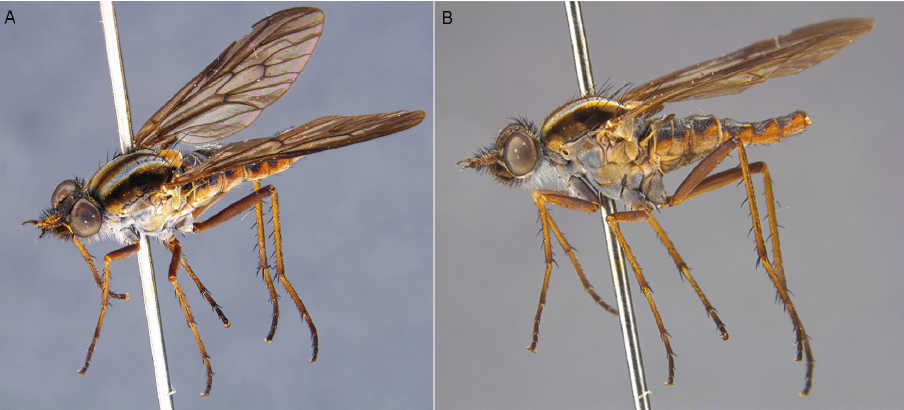
Figure 12. Sidarena hortorum sp. n.: A Male oblique view B same, lateral view (terminalia Sidarena hortorum sp. n.